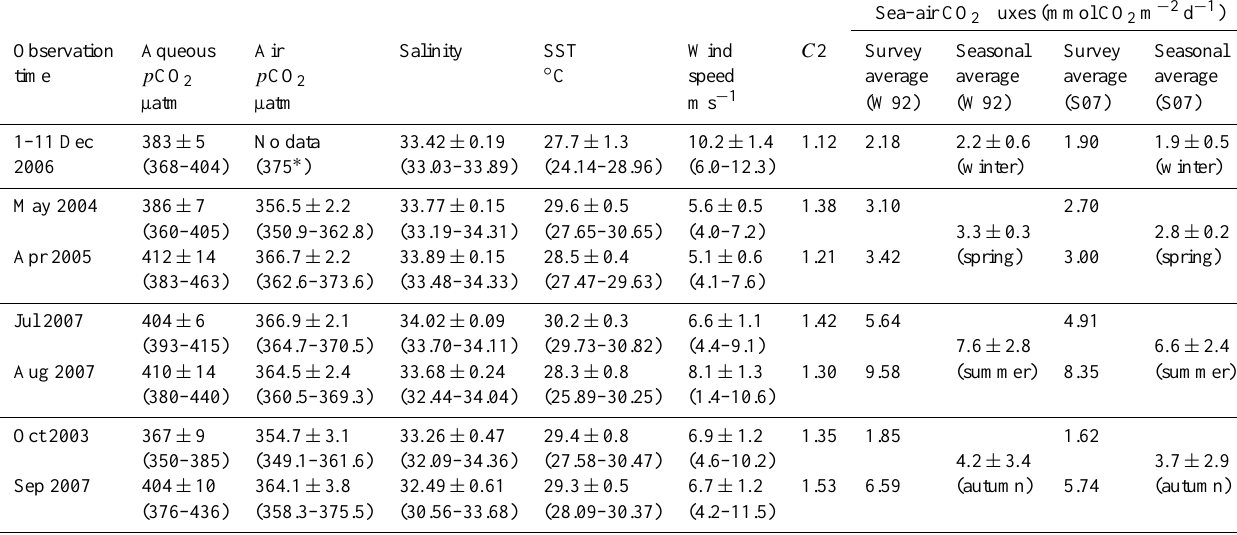
Table 5. Summary of p CO 2 , salinity and SST along cruise tracks, monthly satellite-derived wind speed, and sea–air CO 2 flux estimation in